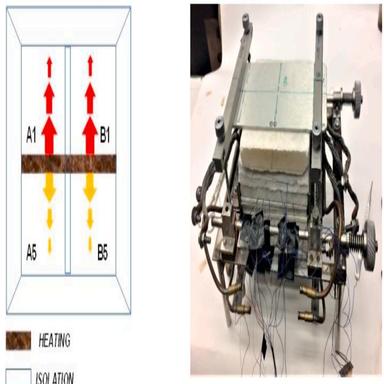
Experimental set-up for heat transport properties analysis: simplified schematics illustrating the heat transport measuring concept (left), the experiment module with installed specimens and thermo-insulating holder (right).